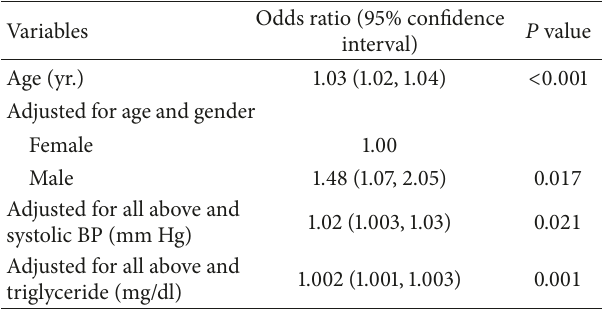
Table 3: Impact of sequential adjusted risk factors related to mean 16-year incidence of hypertension for patients with type 1